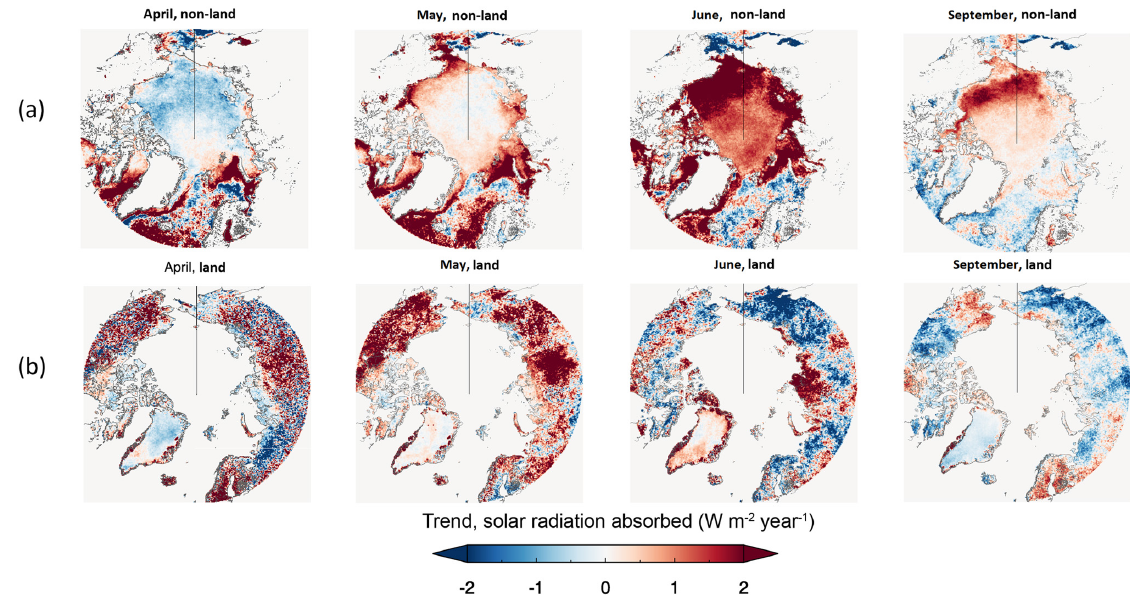
Figure 2. Trends in absorbed radiation for selected months over ocean (a) and land (b)